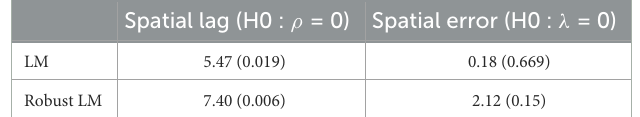
TABLE 3 Lagrange multiplier tests. Spatial lag (H0 : ρ = 0) Spatial error (H0 : λ = 0)